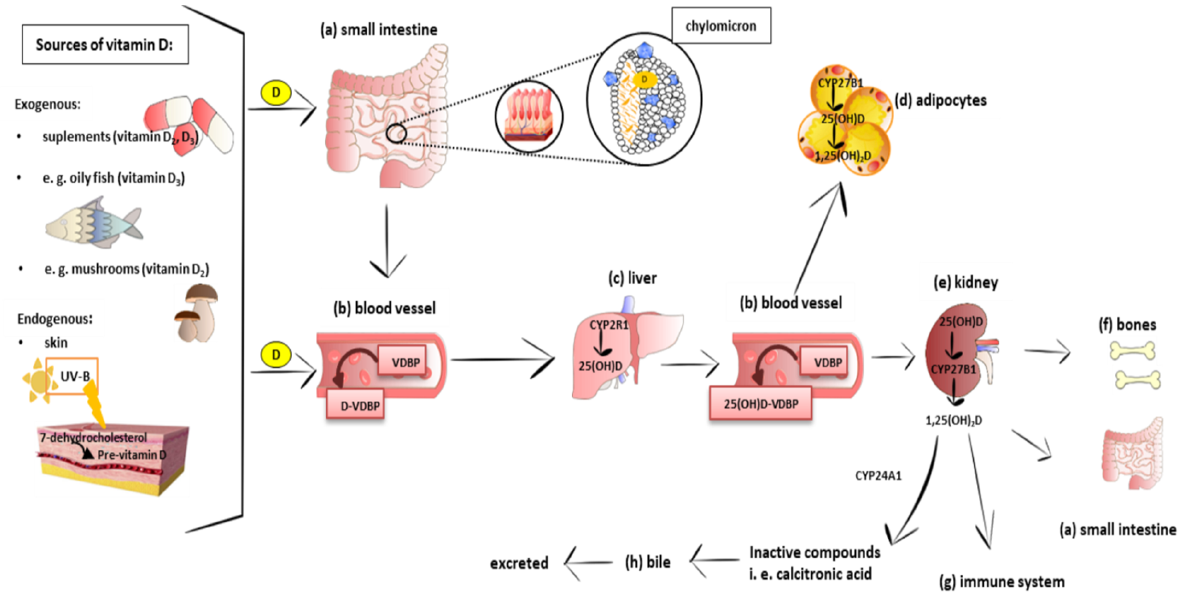
Figure 1. Schematic absorption, distribution, metabolism, and clearance of vitamin D indicating the strategic tissues/organs involved ( a – h ) and sources of the molecule. Main exogenous source of vitamin D are oily fish and mushrooms, apart from pharmaceutical supplements. The other source of the molecule is its synthesis in the epidermis layer of the skin. Under the influence of ultraviolet (UVB) radiation, 7-dehydrocholesterol undergoes nonenzymatic photoisomerization into pre-vitamin D. Next, pre-vitamin D is transformed into cholecalciferol in a heat-dependent process and comes out of the skin to the blood and binds to vitamin D-binding protein (VDBP) ( b ). Vitamin D from the diet is transported in blood mainly in chylomicrons ( a ). Next, both skin and diet-derived vitamin D reach the liver ( c ) and is hydroxylated into 25(OH)D (calcidiol) by 25-hydroxylase (CYP2R1). 25(OH)D leaves the liver and is bound to VDBP ( b ), which presents the highest affinity to calcidiol. 25(OH)D-VDBP is the major circulating form of vitamin D. Then, calcidiol is internalized by target tissues, mostly the kidneys ( e ), where it is transformed into the active form 1,25(OH) 2 D (calcitriol) by 1-hydroxylase (CYP27B1). CYP27B1 is expressed not only in the kidneys but also in numerous different cells, including adipocytes ( d ). The main function of vitamin D is to regulate calcium and phosphate homeostasis. The two main effector organs related to this function, on which the active metabolites of vitamin D act, are the intestines ( a ) and bones ( f ), and the molecule also exerts immunomodulatory effects ( g ). Calcitriol is able to stimulate its own degradation by the induction of 25(OH)D-24-hydroxylase (CYP24A1). CYP24A1 is an enzyme degrading both calcitriol and its precursor calcidiol to biological inactive metabolites, including calcitroic acid, which is excreted with bile ( h ). Abbreviations: D 2 , egrocalciferol, plant origin vitamin D; D 3 , cholecalciferol, animal origin food vitamin D; UVB, ultraviolet radiation; SR-B1, scavenger receptor class B type 1; CD36, class B scavenger receptor; NPC1-L1, Niemann-Pick C1-Like 1; CYP2R1, cytochrome P450 family 2 subfamily R member 1; CYP24A1, cytochrome P450 family 24 subfamily A member 1; CYP27B1, cytochrome P450 family 27 subfamily B member 1; CYP24A1, cytochrome P450 family 24 subfamily A member